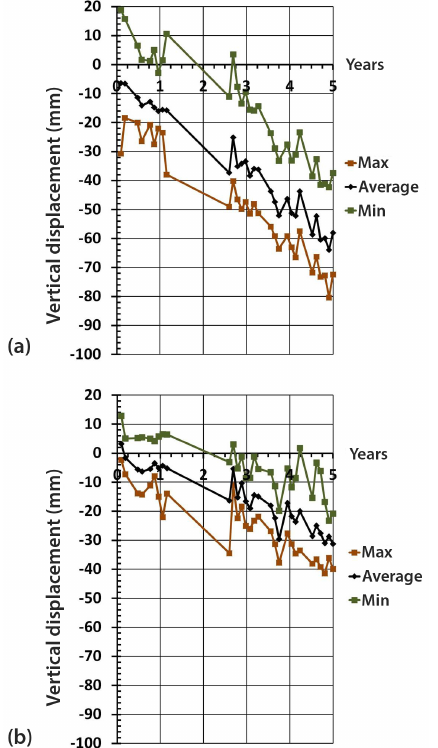
Figure 11. Evolution of uplift over 5-year time zone in the sec- ond observation period (from mid-September 2005 through mid- September 2010): (a) 10 reflectors around coordinates 51.036 ◦ N,